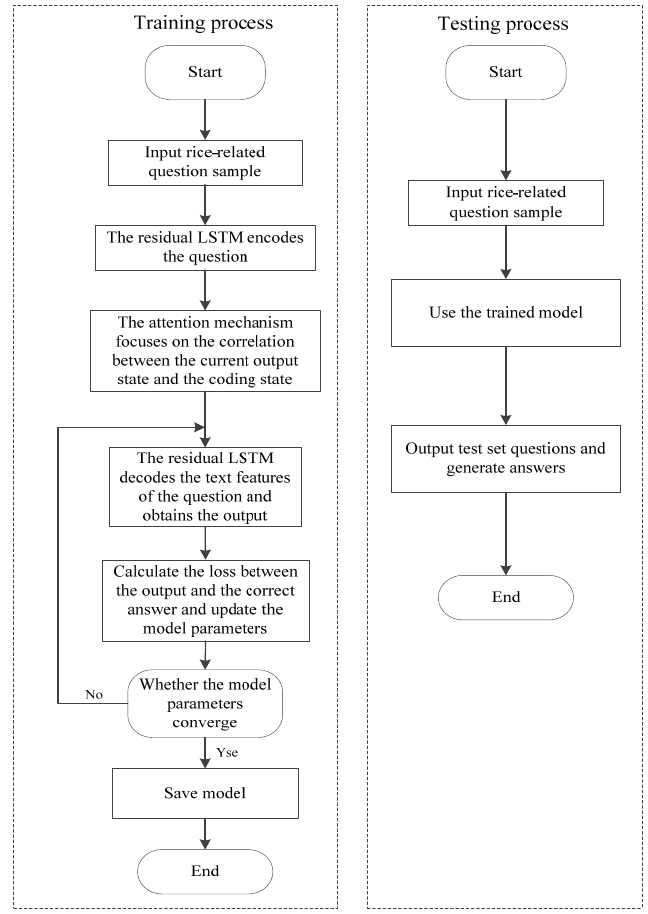
Figure 7. Model training and testing process.